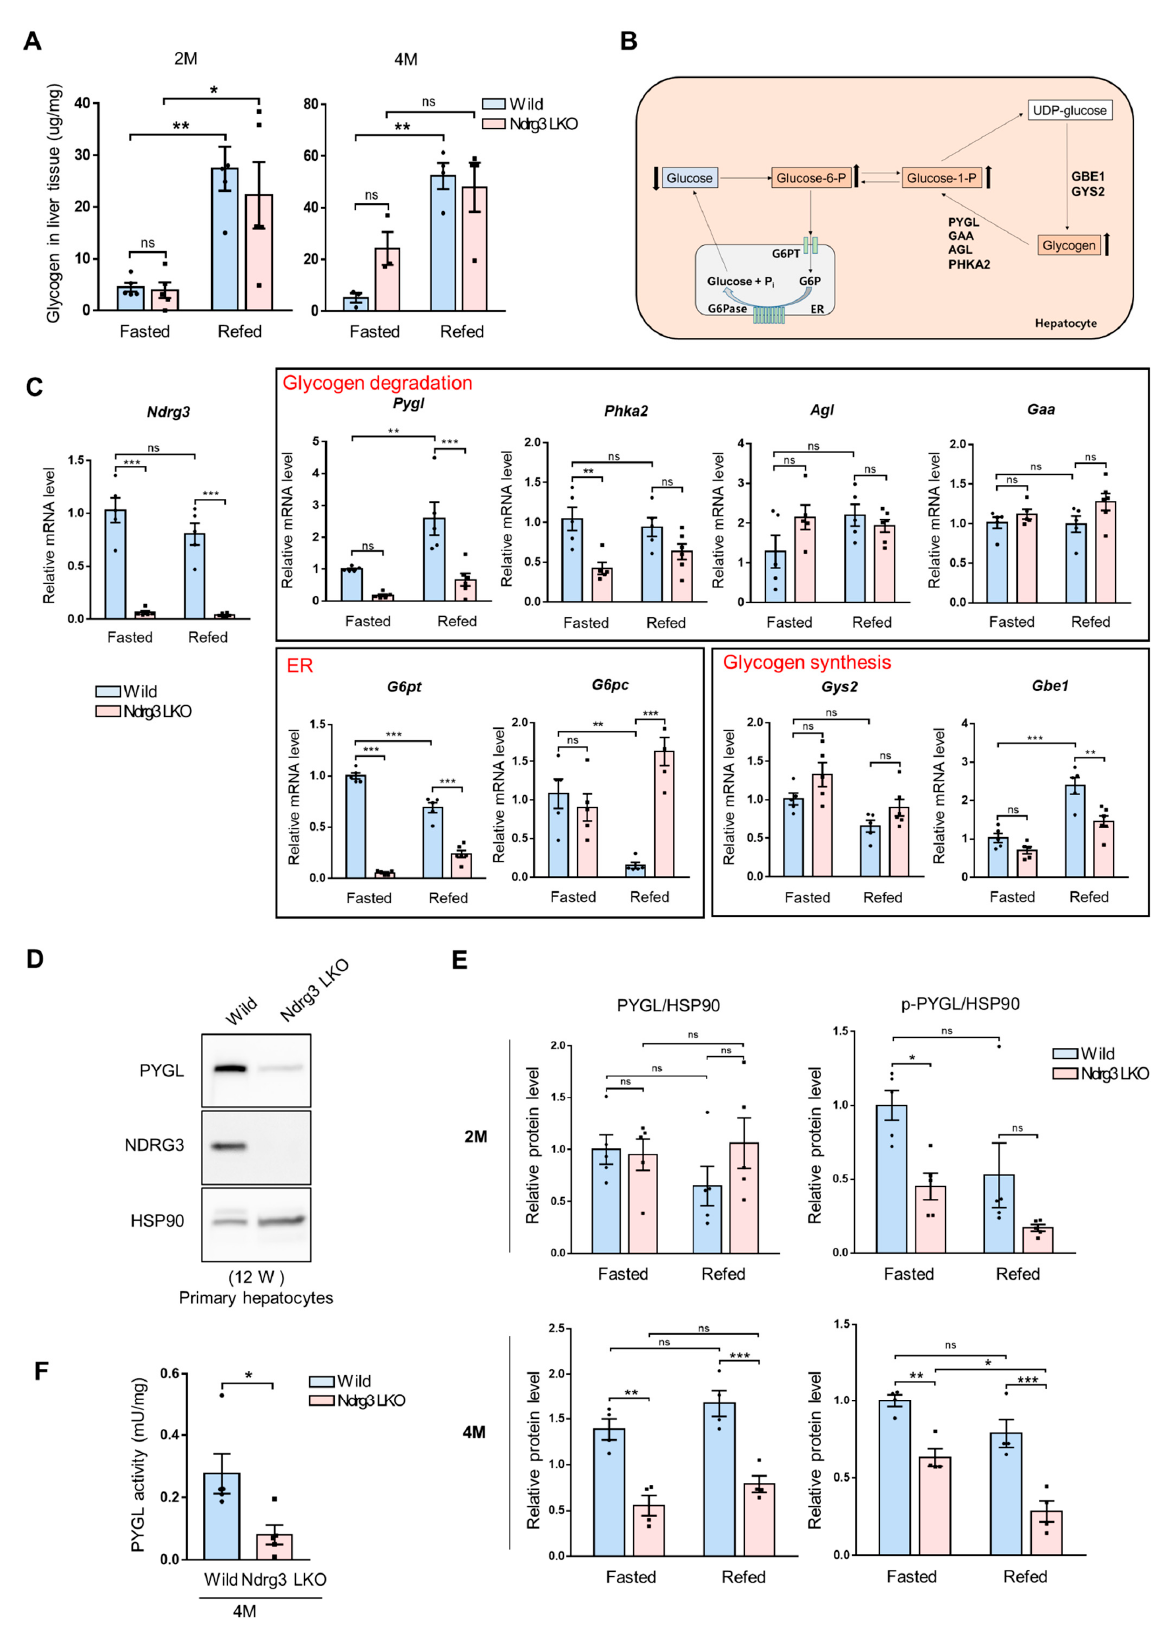
Figure 4. Impaired glycogenolysis in Ndrg3 LKO livers due to dysregulation of genes in glycogen degradation pathway. ( A ) Quantitative measurement of hepatic glycogen volumes depending